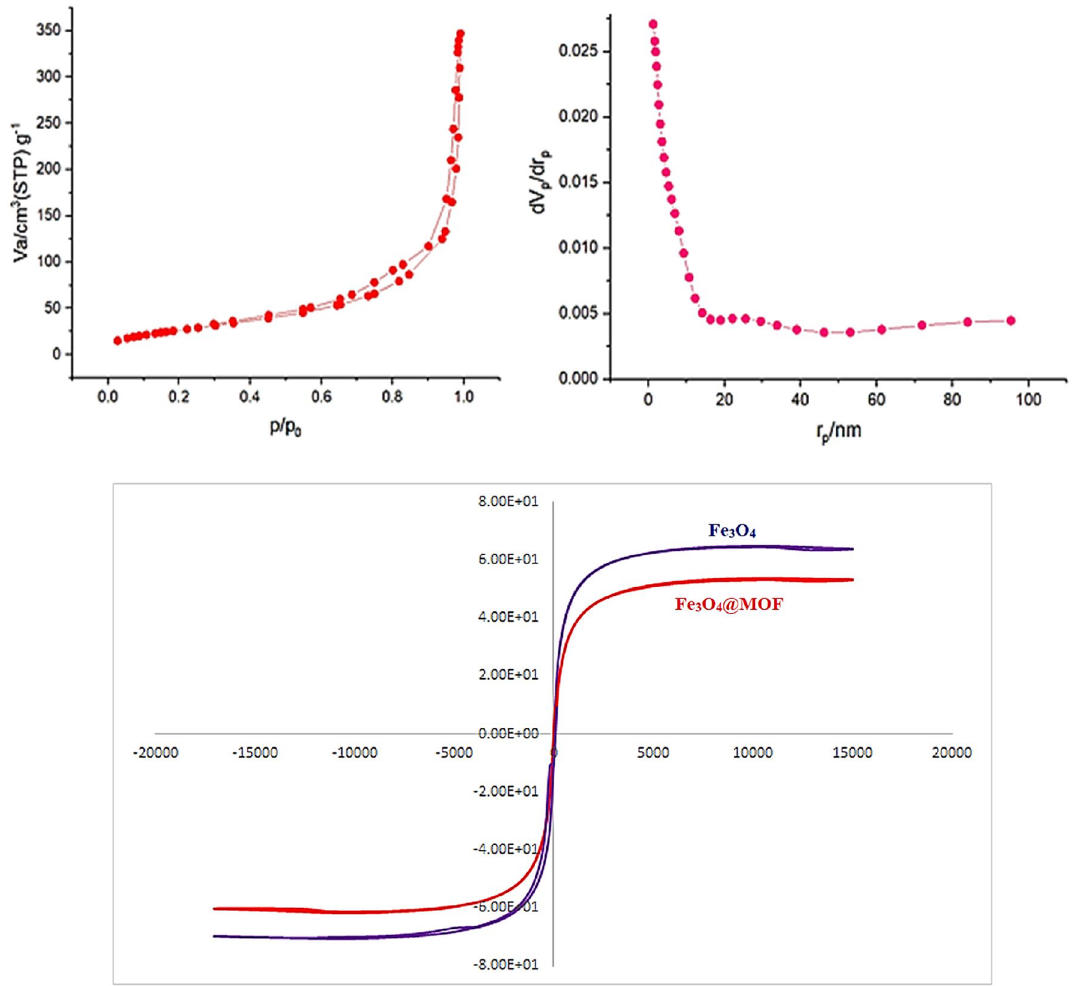
Figure 8. Fe 3 O 4 @MIL-101(Cr)-N(CH 2 PO 3 ) 2 : ( a ) BET and BJH isotherms, ( b )